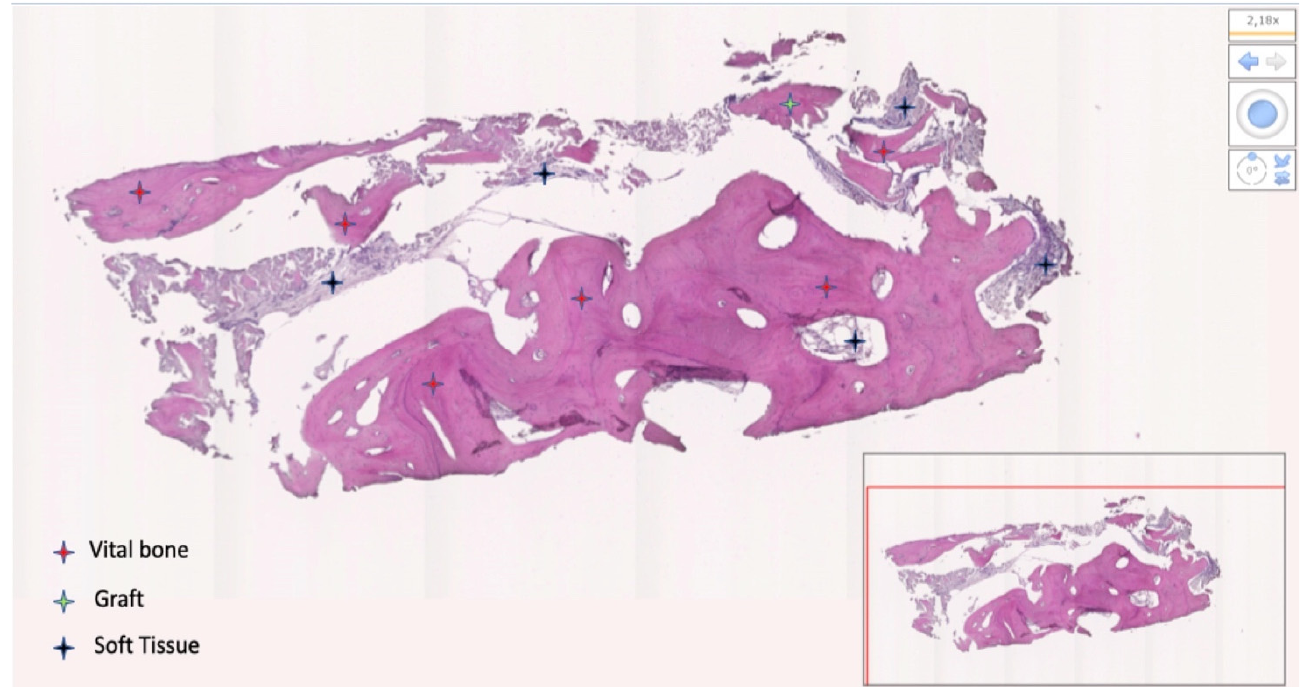
Figure 11. Bone sample taken at the lower right first molar. Patient (number 3) received L-PRF mixed with decellularized bovine compact bone from bovine femur (test group). The bone was 76.65%; soft tissue was 8.73%; residual graft was 15.62%.